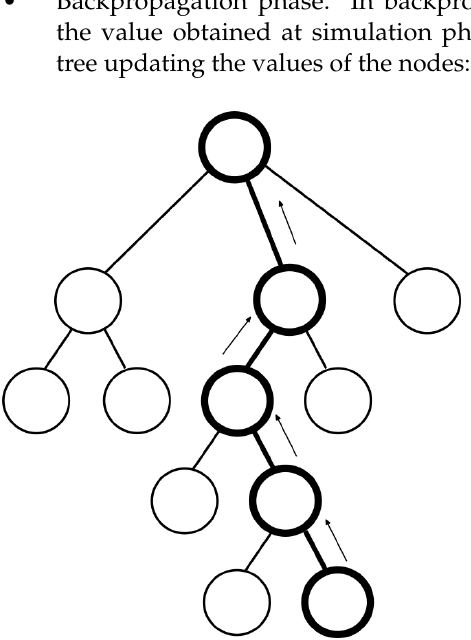
Figure 5. Backpropagation phase in